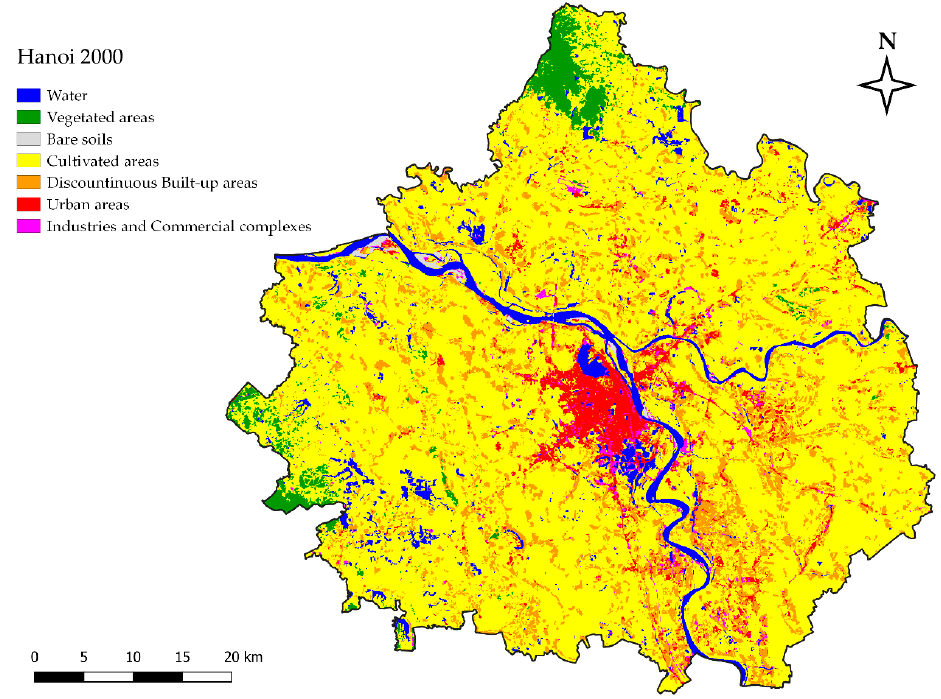
Figure 7. The 2000 LULC map of the study area.